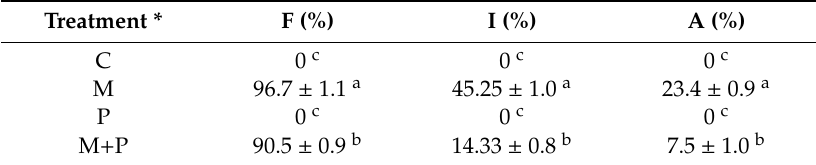
Table 4. Levels of mycorrhizal colonization in sunflower plants treated with R. irregularis in response to the infection with R. solani (28 days after inoculation with R. solani